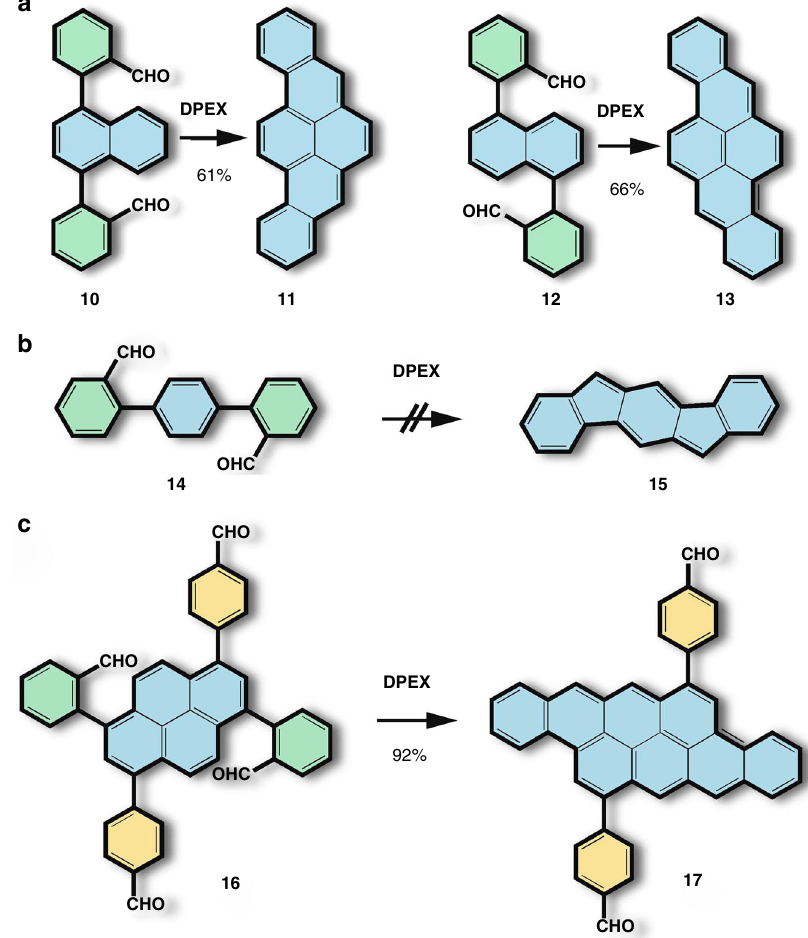
Fig. 3 The scope of the DPEX protocol. a Reaction with less reactive naphthalene core units; b No formation of fi ve-membered rings; c Tolerance towards misplaced formyl